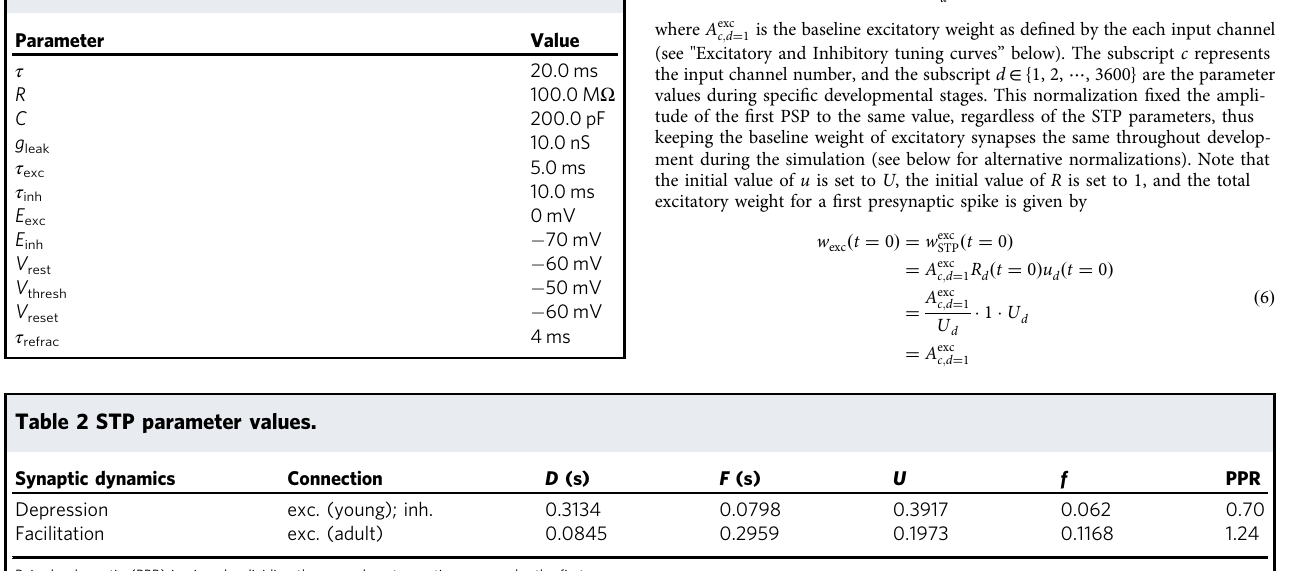
Table 1 Parameter values for conductance-based leaky integrate-and- fi re